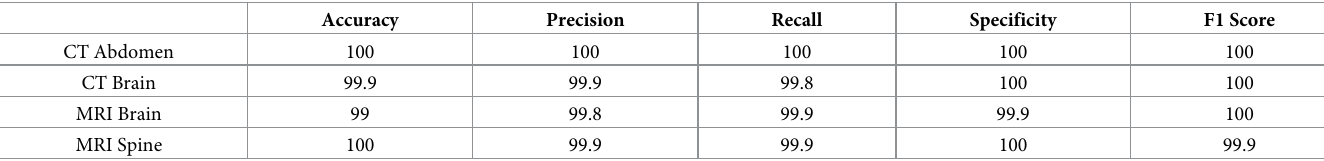
Table 5. Overall performance measures of our CNN architecture on validation set (In